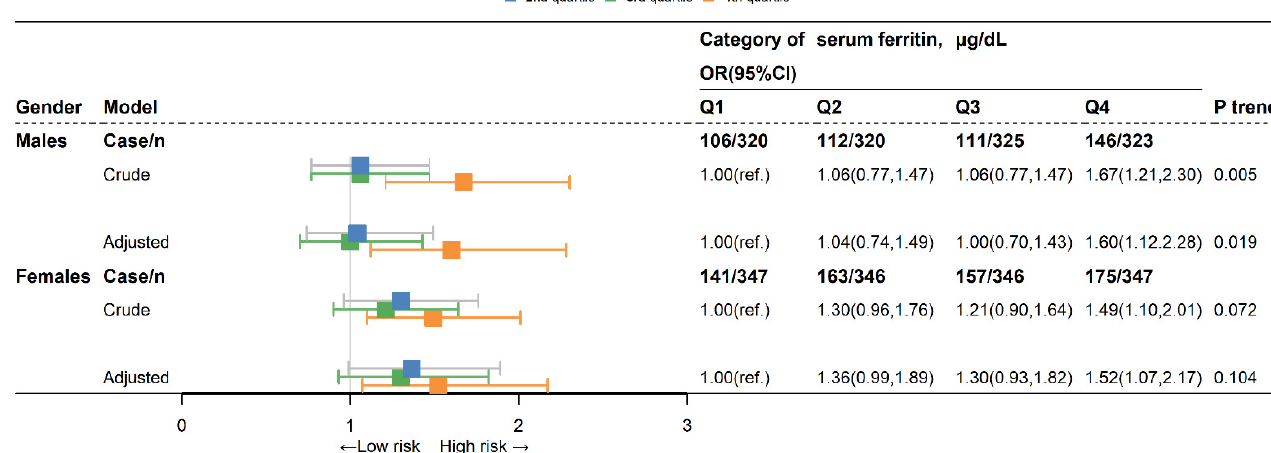
Figure 2. ORs (95% CIs) for dyslipidemia according to serum ferritin in males and females. OR, odds ratio; CI, confidential intervals; Q1: 1st quartile, Q2: 2nd quartile, Q3: 3rd quartile, Q4: 4th quartile; TC, total cholesterol; LDL-C, low-density lipoprotein cholesterol; TG, triglyceride; HDL-C, high- density lipoprotein cholesterol. OR and 95% CI were obtained by multivariable logistic regression analysis (crude models). The adjusted models were adjusted for age, race, six-month time period, educational level, marital status, BMI, hypertension, smoking status, alcohol status, total daily energy intake, and total daily fat intake.